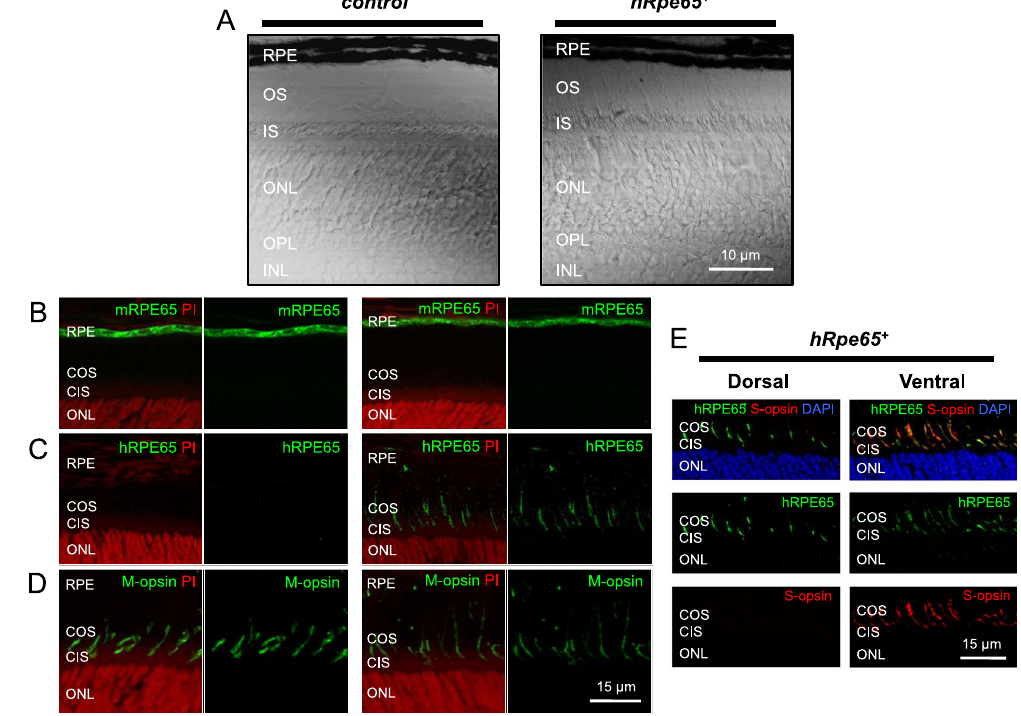
Figure 5. Transgenic expression of human RPE65 in normal cones lacking endogenous RPE65 protein. ( A ) Retinal morphology in control Gnat1 − / − and transgenic Gnat1 − / − hRpe65 + mice. Confocal images in transmitted light. RPE: retinal pigmented epithelium; OS: photoreceptor outer segments; IS: photoreceptor inner segments; ONL: outer nuclear layer; OPL: outer plexiform layer; INL: inner nuclear layer. Scale bar, 10 μ m. ( B ) Absence of endogenous RPE65 in cones of control Gnat1 − / − (left) and transgenic Gnat1 − / − hRpe65 + (right) mice. Expression of mouse RPE65 (mRPE65), examined by immunohistochemistry with PETLET RPE65 antibody (green), was restricted to the RPE. Cell nuclei were stained with propidium iodate (red). RPE: retinal pigmented epithelium; COS: cone outer segments; CIS: cone inner segments; ONL: outer nuclear layer. ( C ) Human RPE65 (hRPE65, DALEED antibody, green) is expressed in retinas of transgenic (right) mice but not in control (left) retinas. Cell nuclei were stained with propidium iodate (red). RPE: retinal pigmented epithelium; COS: cone outer segments; CIS: cone inner segments; ONL: outer nuclear layer. ( D ) Normal cone density and morphology in retinas of control (left) and transgenic (right) animals. Expression of M-opsin was examined by immunohistochemistry with rabbit M-opsin antibody (green). Cell nuclei were stained with propidium iodate (red). RPE: retinal pigmented epithelium; COS: cone outer segments; CIS: cone inner segments; ONL: outer nuclear layer. Scale bar in ( B – D ), 15 μ m. ( E ) Transgenic human RPE65 (green) is also expressed in ventrally-located retinal S-cones (bottom) that are not present in the far dorsal area of the retina (top), as evidenced by immunostaining with S-opsin antibody (red). Cell nuclei were stained with DAPI (blue). COS: cone outer segments; CIS: cone inner segments; ONL: outer nuclear layer. Scale bar, 15 μ